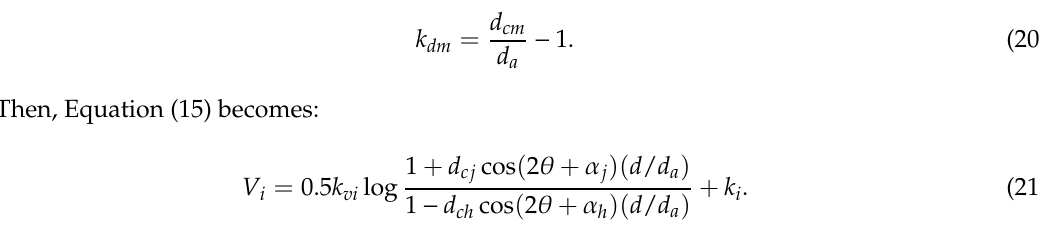
Figure 15. Photograph of indoor calibration setup.